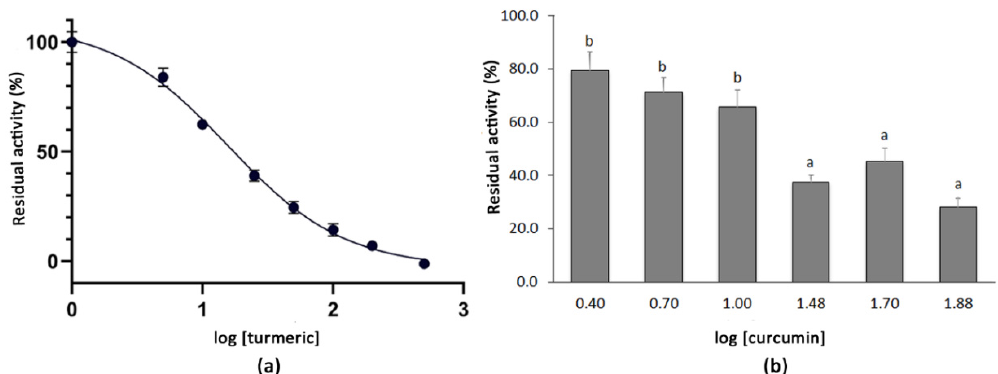
Figure 2. ( a ) Dose–response curve for the methanolic extract of turmeric powder. Each point represents the average value and SE for the residual activity of the 3CL Pro (%) at extract concentrations between 5.0 and 500 µg mL − 1 ( n = 4). The 100% of residual activity considers the activity of the 3CL Pro when no inhibitor is added. ( b ) Mean residual activity and SE of 3CL Pro (%) determined after the co-incubation with five different concentrations of commercial curcumin (2.5–75 µg mL − 1 ) ( n = 4). Different letters indicate significant differences in the 3CL Pro residual activity according to a Student–Newman– Keuls test at p < 0.05.